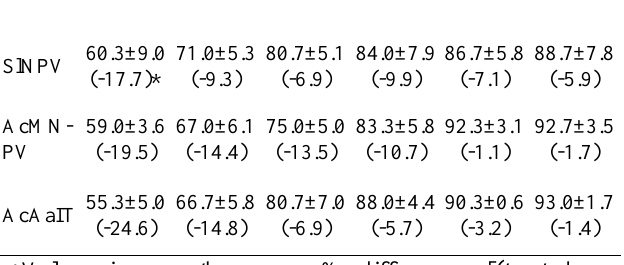
*Values in parentheses are % differences [(treated – control)/control x